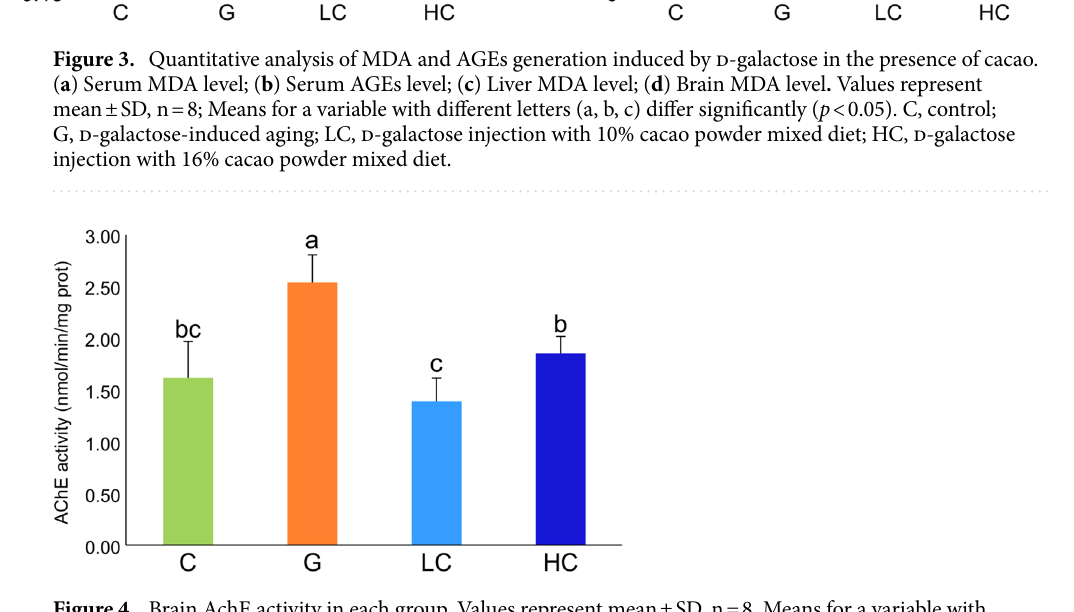
Figure 4. Brain AchE activity in each group. Values represent mean ± SD, n = 8. Means for a variable with different letters (a, b, c) differ significantly ( p < 0.001). C, control; G, d-galactose-induced aging; LC, d-galactose injection with 10% cacao powder mixed diet; HC, d-galactose injection with 16% cacao powder mixed